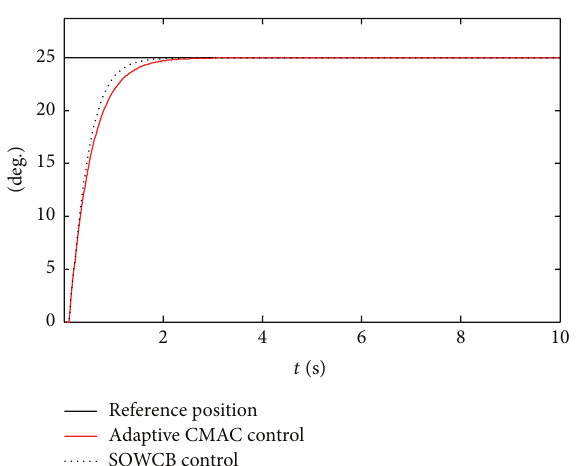
Figure 6: The moment of inertia changes step response curve.